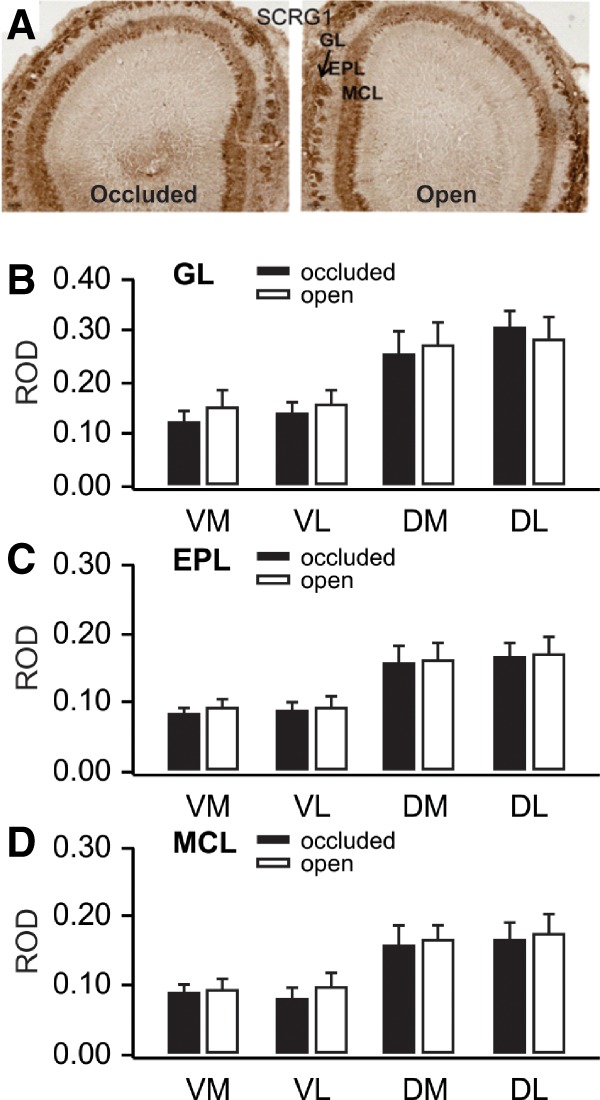
(A) Scrg1 immunohistochemical staining in olfactory bulbs ipsilateral to occluded and open nares 50 min following odor + stroking training. (B) Glomerular layer ROD values for olfactory bulb quadrants receiving input from occluded and open nares. (C) External plexiform ROD values for olfactory bulb quadrants receiving input from occluded and open nares. (D) Mitral cell layer ROD values for olfactory bulb quadrants receiving input from occluded and open nares. Error bars represent SEMs.